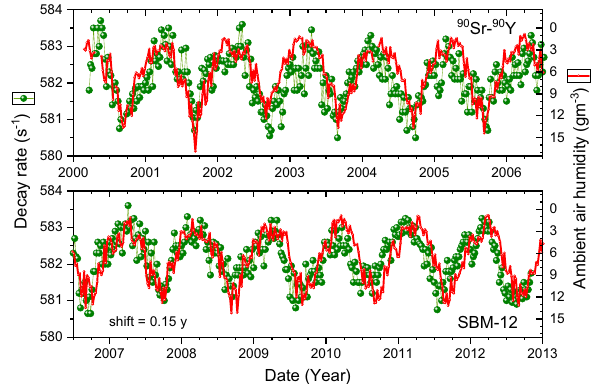
Figure 4. Decay-corrected count rates of 90 Sr/ 90 Y beta decay obtained with the SBM-12 G–M counter (dots), compared to absolute humidity in Moscow calculated from weather data shifted in time by 0.15 year to the right (line).